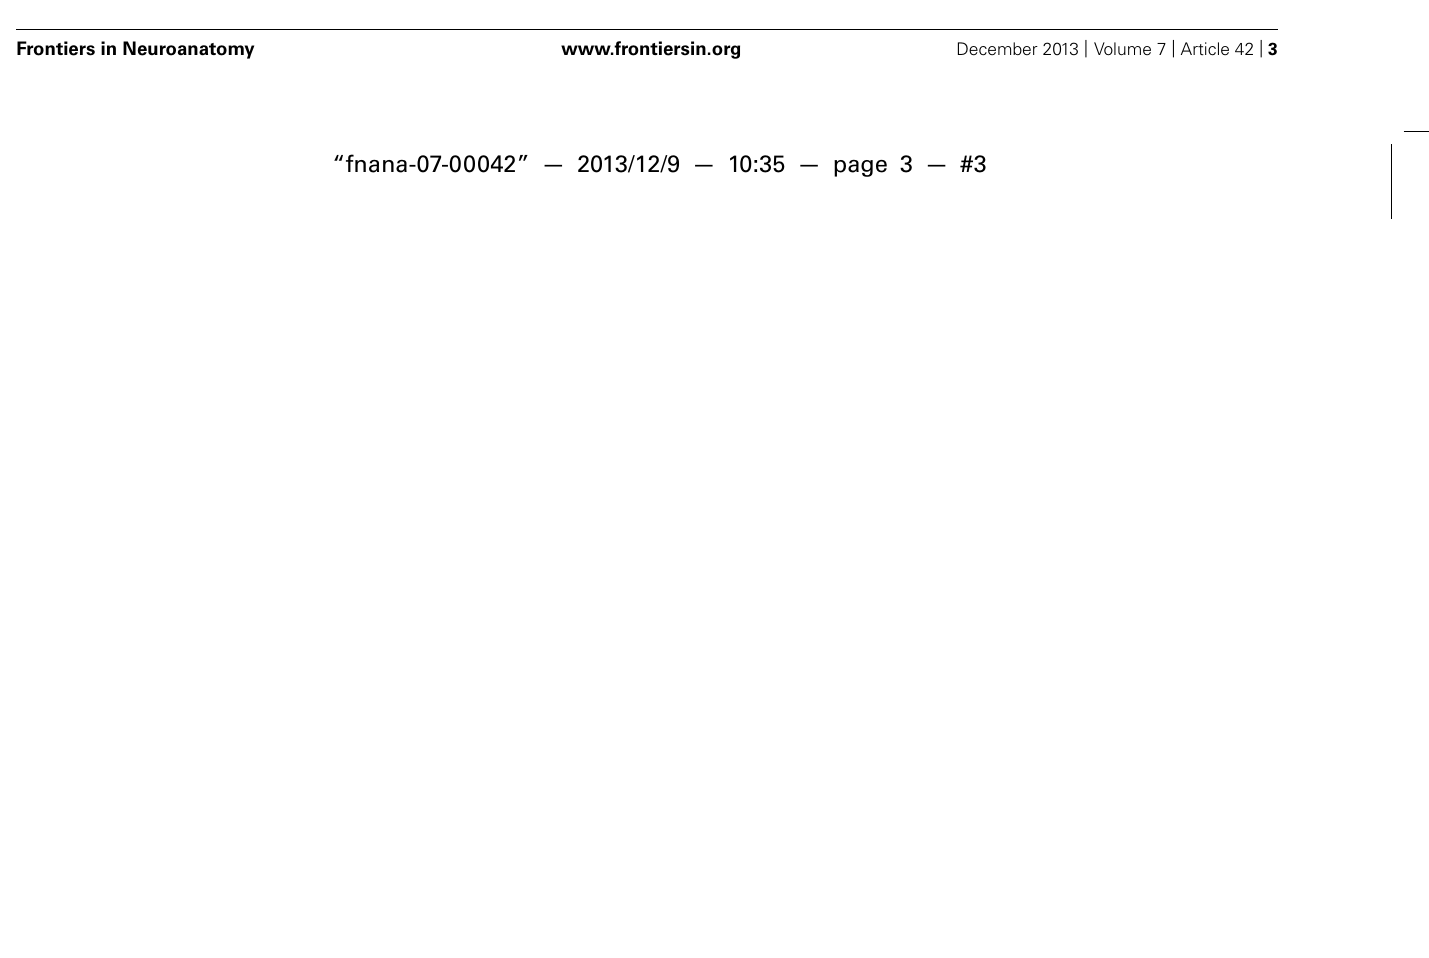
obtained from a different section, in the approximate position indicated by the rectangle in (A) . Double-labeled cells for GFP and BrdU were distributed in the ventral horn (arrowheads). (D) Distribution of E11.5-birthdated BrdU-positive nuclei in the spinal cord. (E,G–I) Double-labeled cells for GFP and BrdU were highly concentrated in the spinal dorsal horn after injection of BrdU at E11.5. Double-labeled cells are indicated by white arrowheads. The borders of the spinal cord lamina are depicted as dashed lines. In (A) , “d” is dorsal; “v,” ventral; and “cc” indicates the central canal. The same section orientation is maintained in the following figures. Scale bars = 100 μ m in (B,D,E) and 10 μ m in (B,I) (applies to G–I